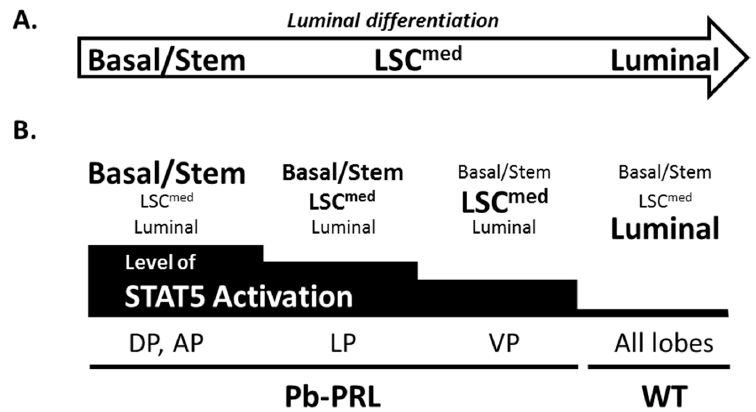
Figure 7. STAT5 signaling prevents luminal di ff erentiation of the prostate epithelium. ( A ). Schematic representation of luminal di ff erentiation placing LSC med cells in-between basal and luminal cells. ( B ). The relative content in the three epithelial cell populations (basal / stem, LSC med , luminal) in the various prostate lobes of 6-month old Pb-PRL mice or in WT mice (any lobe), as determined in Figure 3 is symbolized by the size of each population name. Below, the level of STAT5 activation in each lobe as determined in Figure 1 is also schematically represented by the black stair-bar. Based on these measurements, the highest the level of STAT5 activation, the lowest the level of epithelium di ff erentiation was observed (see text for discussion).